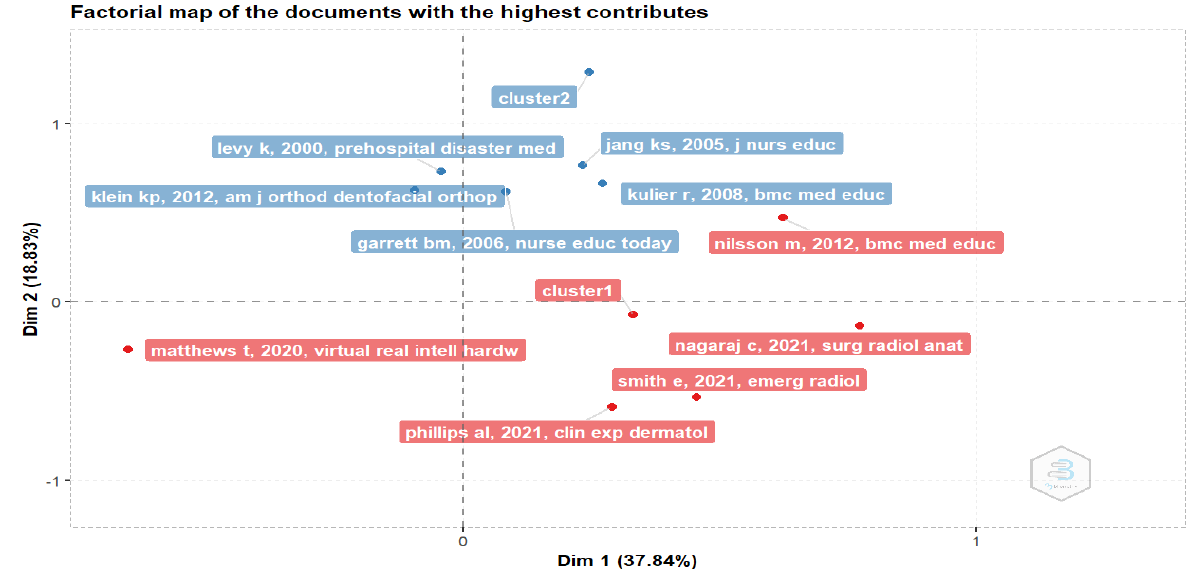
Figure 14. Factorial map of the document with the highest contributions. Cluster 2: The second cluster identified six papers dating back to the pre-covid